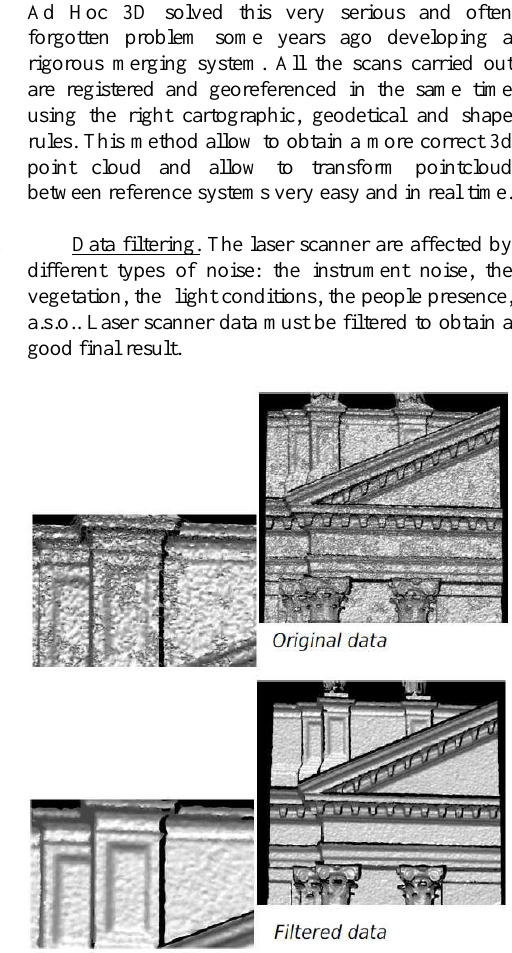
Figure 1. Filtering noise in laser scanner acquisitions